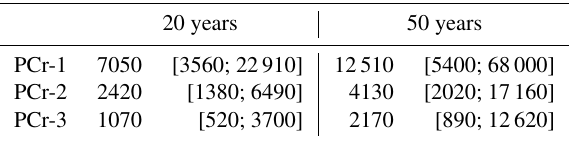
Table 5. BA (ha) corresponding to different return periods (years), by area and for the recent period (1995–2016). Intervals between brackets indicate 90% credible intervals of the corresponding return